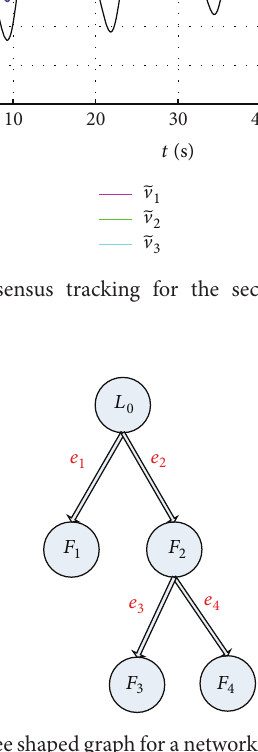
Figure 4: The tree shaped graph for a network of four followers with a leader, where 𝐿 0 denotes the leader and 𝐹 𝑖 , 𝑖 = 1, 2, 3,4 , denote the followers. The direct arrows represent the information flow from the parent agent to the child agent.